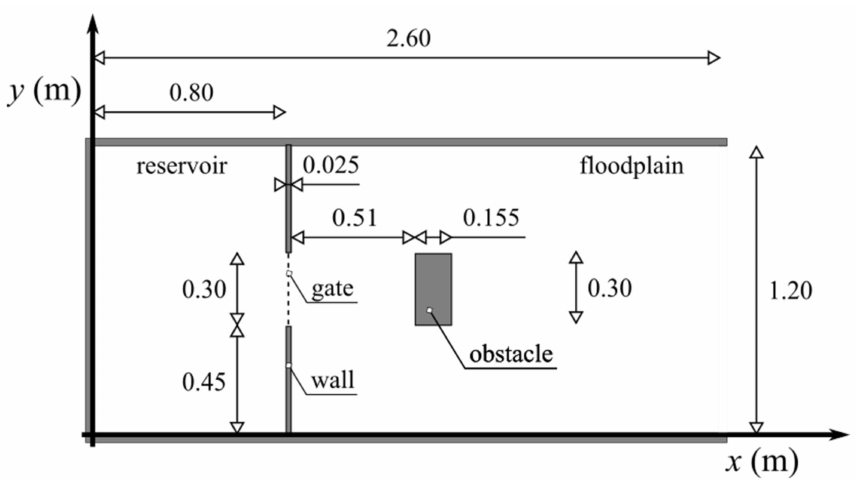
Figure 1. Sketch of the considered test